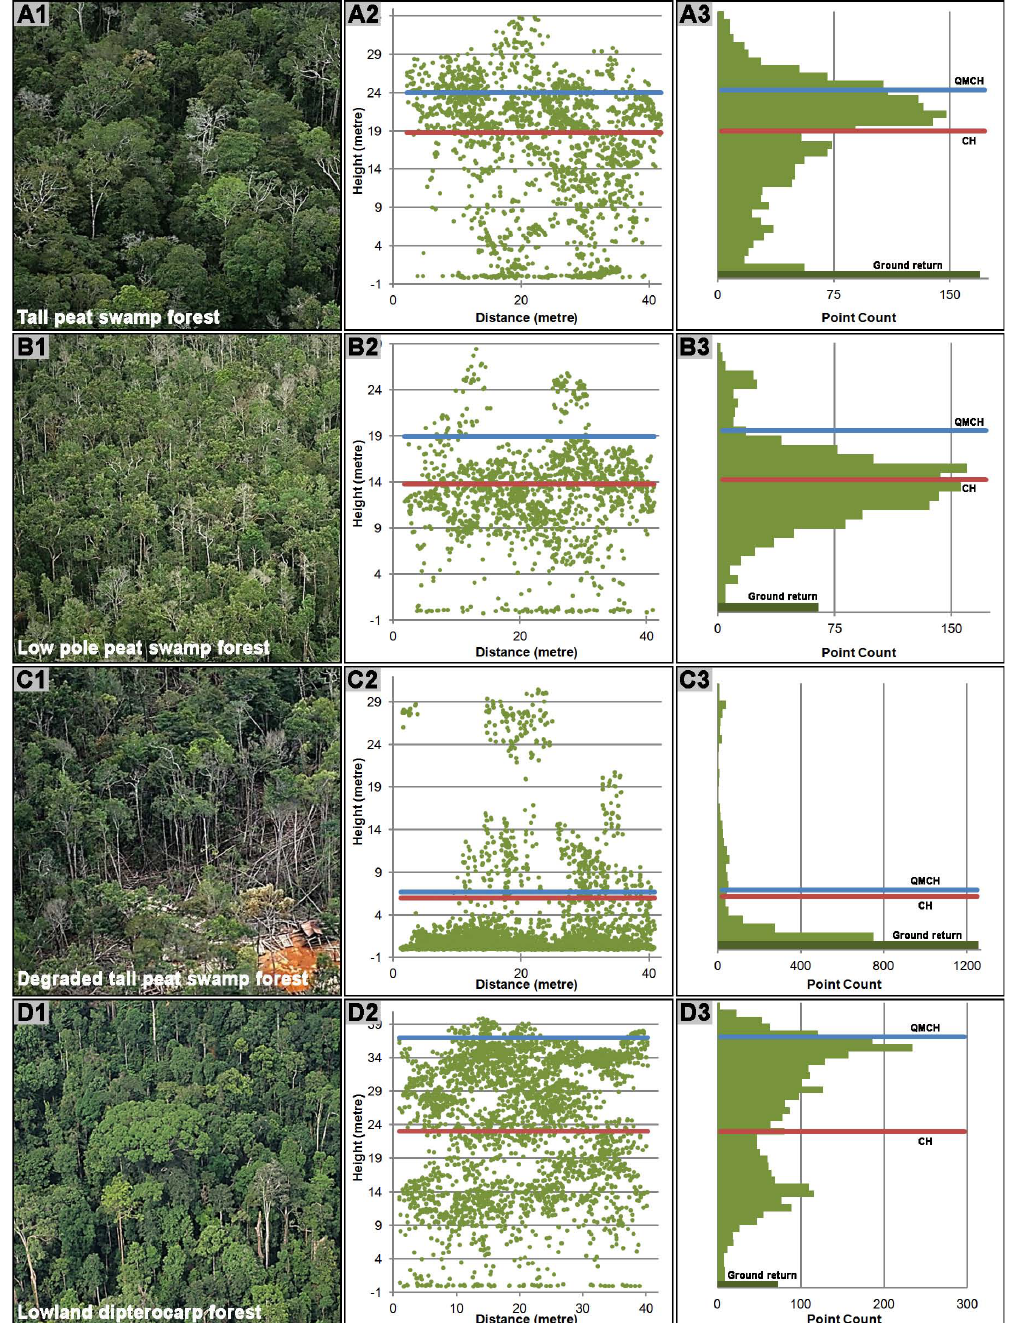
Fig. 3. Sample data set for each of the four investigated forest types. (A1) to (A3) show tall peat swamp forest (AGB = 57.61t 0.13ha − 1 ; LiDAR point density = 1.5ptm − 2 ; centroid height (CH) = 18.7m; quadratic mean canopy profile height (QMCH) = 24.0m). Note that CH and QMCH are in the upper canopy of the forest. (B1) to (B2 ) show low pole peat swamp forest (AGB = 19.12t 0.13ha − 1 ; LiDAR point density = 1.1ptm − 2 ; CH = 13.7m; QMCH = 18.9m). (B3) shows the forest structure (a small peak at about 24m representing emergent trees and a large peak at about 14m representing the main canopy layer). (C1) to (C3) show logged tall peat swamp forest (AGB = 5.05t 0.13ha − 1 ; point density = 2.9ptm − 2 ; CH = 5.8m; QMCH = 6.2m). The small peak in (C2) at about 26m height indicates remaining tall trees. (C3) clearly shows the predominant ground return. CH and QMCH are located at similar heights. (D1) to (D3) show lowland dipterocarp forest (AGB = 108.20t 0.13ha − 1 ; LiDAR point density = 2.3ptm − 2 ; CH = 25.3m; QMCH = 35.3m). The two peaks in (D3) (at about 14m and 34m) indicate a complex multilayered forest